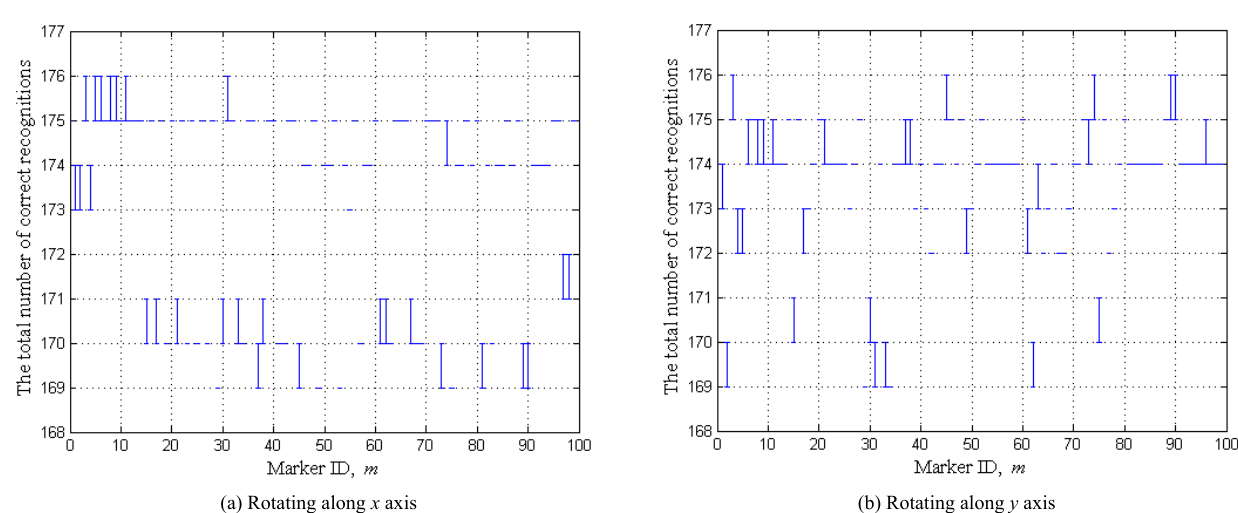
(a) Rotating along x axis (b) Rotating along y axis Fig. 5. Limits of the total number of correct recognitions of individual markers evaluated under marker rotation in four virtual environment scenes.